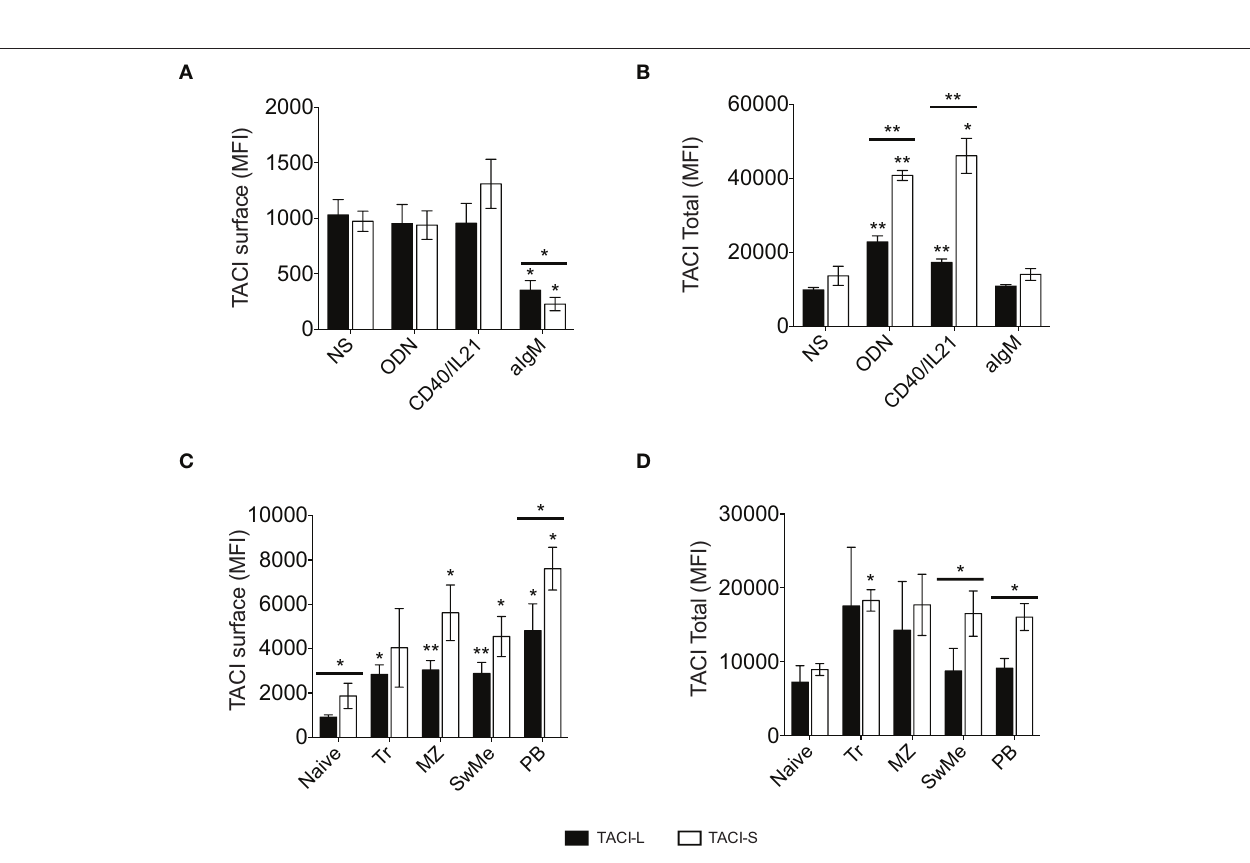
FIGURE 9 | TACI isoforms expression in activated B cells. TACI isoform expression in non-permeabilized (A) and permeabilized (B) peripheral blood B cells from normal donors, cultured for 4 days in the presence or absence of ODN, CD40L/IL21, or anti-IgM. Data shows the mean ± SEM of 4 independent experiments. (C,D) TACI isoform expression was analyzed in B cell subpopulations isolated from freshly-isolated tonsils ( n = 4): Naïve (IgD + CD27-), Transitional (Tr) (IgM + CD38 + ), Marginal Zone (MZ) (IgD + CD27 + ), Switched Memory (SwMe) (IgD-CD27 + ), and Plasmablasts (PB) (IgD-CD27 hi CD38 hi ). Non permeabilized (C) and permeabilized cells (D) were examined. Data shows the mean ± SEM. * p < 0.05, ** p < 0.01, two-tailed paired Student t -test.